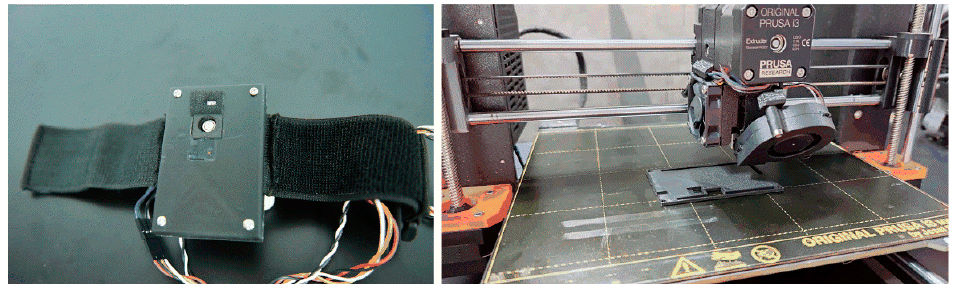
Figure 4. Physical views of the multisensor detection probe and 3D-printed device.